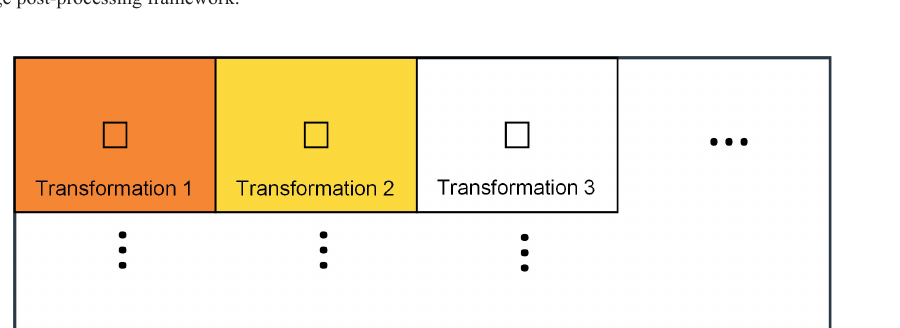
Figure 3. Schematic of CLAHE applied to an image illustrating the different sections (grids) used to compute the transformation